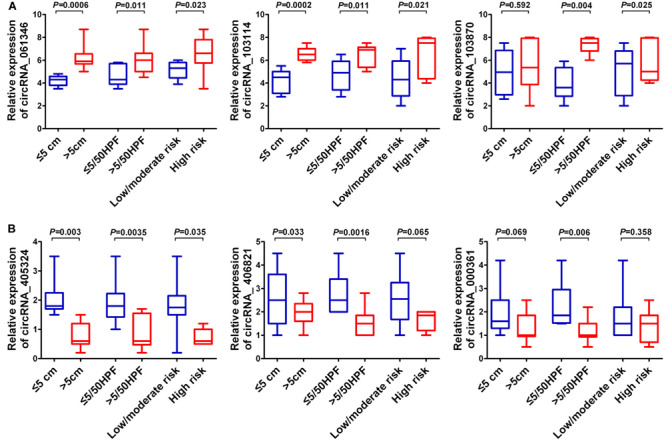
Correlation of six candidate circRNAs with clinical pathologic features. (A) Box plots for three up-regulated circRNAs. (B) Box plots for three down-regulated circRNAs. Tumor size: ≤5 cm, >5 cm; mitotic figure: ≤5/50 HPF, <5/50 HPF; malignant degrees: low risk, moderate risk, high risk.